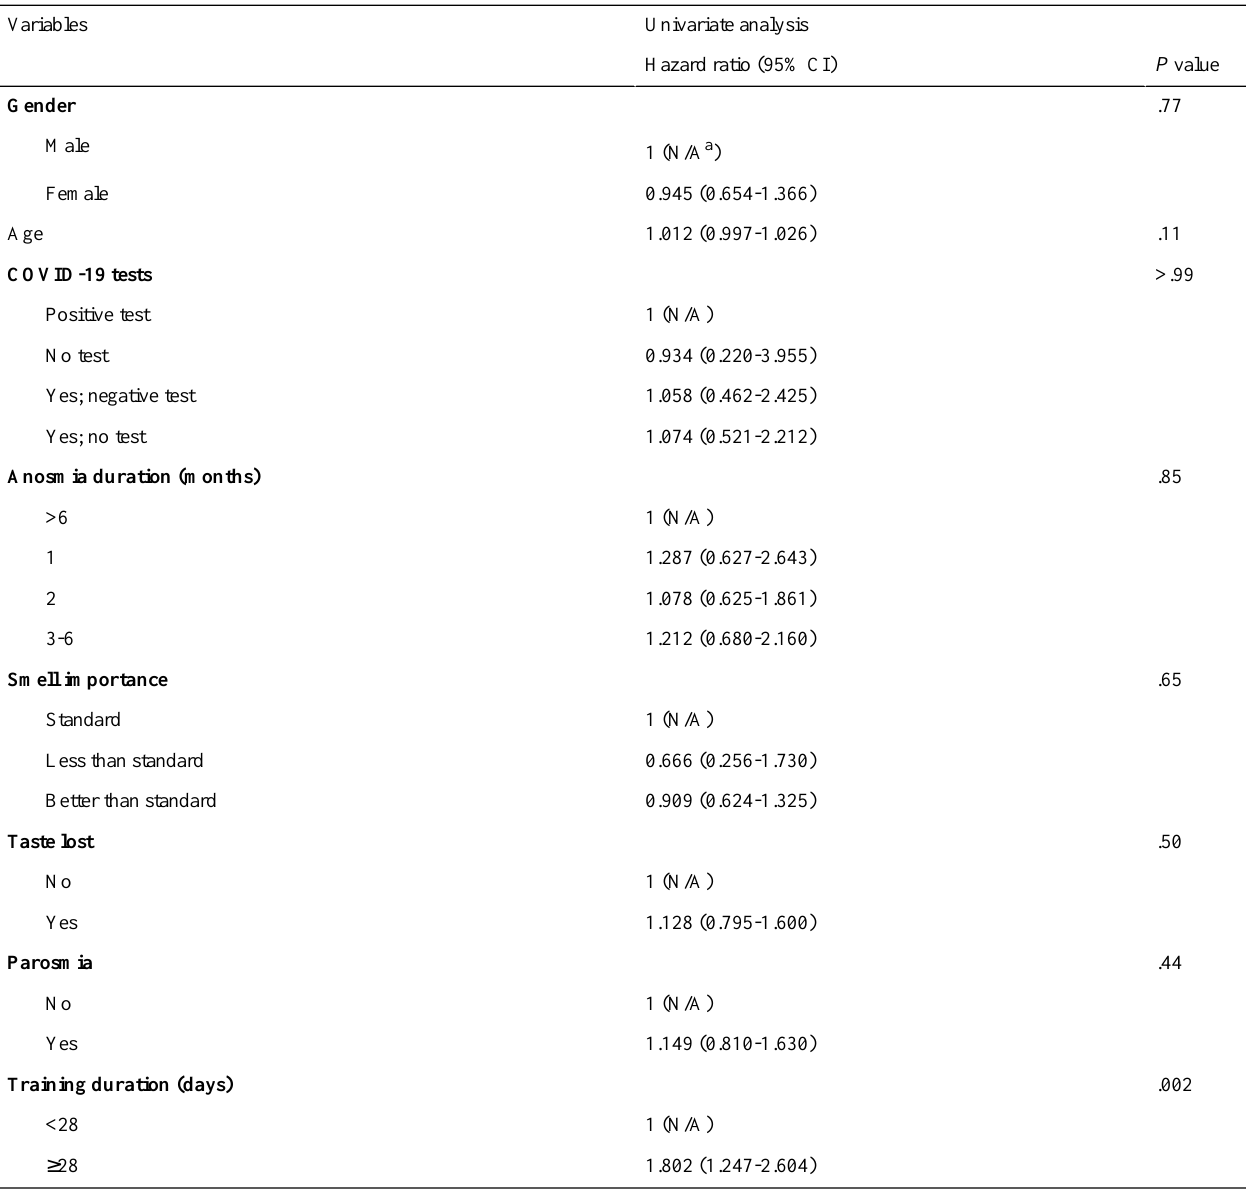
Table 2. Logistic regression analysis for determining the predictive factors of olfactory function improvement (ie, an increase of ≥ 2 points on the olfactory